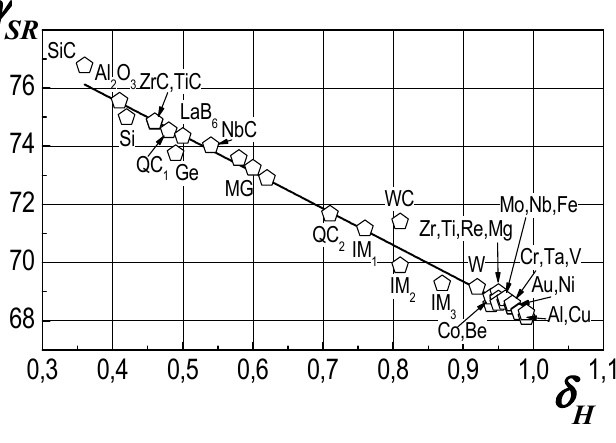
Figure 4. Dependence of the relaxed apex angle of a hardness indent γ SR on the plasticity characteristic δ Н